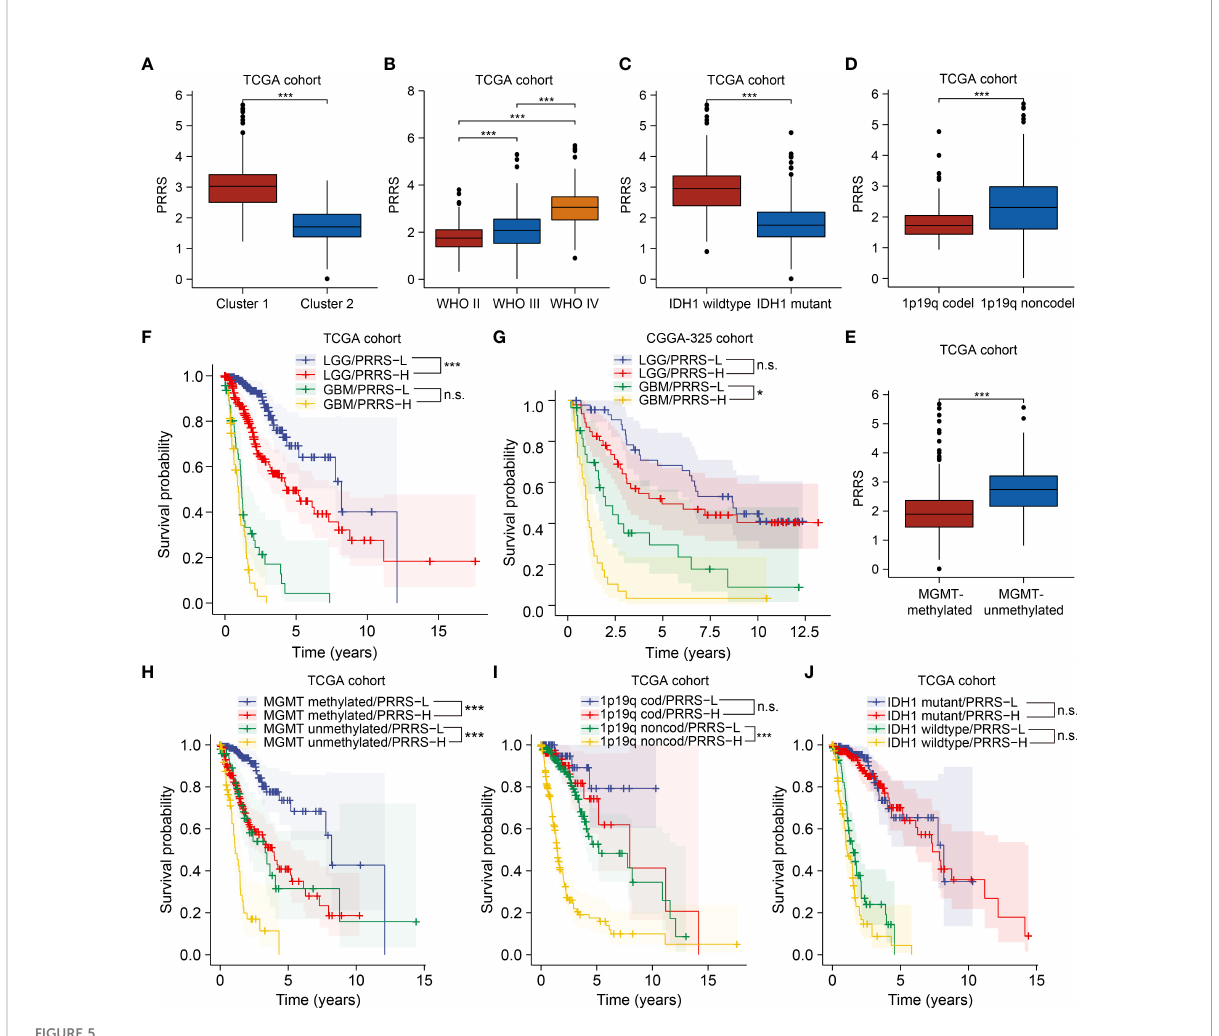
FIGURE 5 The prognostic value of PRRS remains under a subgroup analysis. (A) Comparison of PRRS in Cluster 1 and Cluster 2 in TCGA cohort. (B) Comparison of PRRS in WHO grade II, grade III, and grade IV gliomas in TCGA cohort. (C) Comparison of PRRS in IDH1 wildtype and mutant gliomas in TCGA cohort. (D) Comparison of PRRS in 1p/19q codeleted and non-codeleted gliomas in TCGA cohort. (E) Comparison of PRRS in MGMT promoter methylated and unmethylated gliomas in TCGA cohort. (F) Survival analysis of glioma patients with low and high PRRS in LGG and GBM group, respectively, in TCGA cohort. (G) Survival analysis of glioma patients with low and high PRRS in LGG and GBM group, respectively, in CGGA-325 cohort. (H) Survival analysis of glioma patients with low and high PRRS in co-occurrence with MGMT promoter methylation or not in TCGA cohort. (I) Survival analysis of glioma patients with low and high PRRS in co-occurrence with 1p/19q codeletion or not in TCGA cohort. (J) Survival analysis of glioma patients with low and high PRRS in co-occurrence with IDH1 mutation or not in TCGA cohort. *P < 0.05; **P < 0.005; ***P < 0.001, n.s., not signi fi